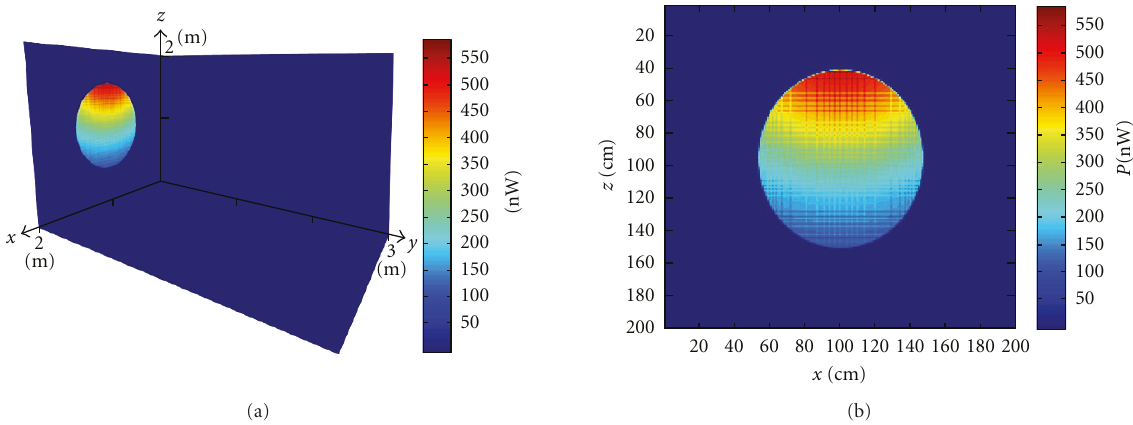
Figure 4: The surface power distributions with rays tracing for one reflection for (a) three walls and (b) one wall.